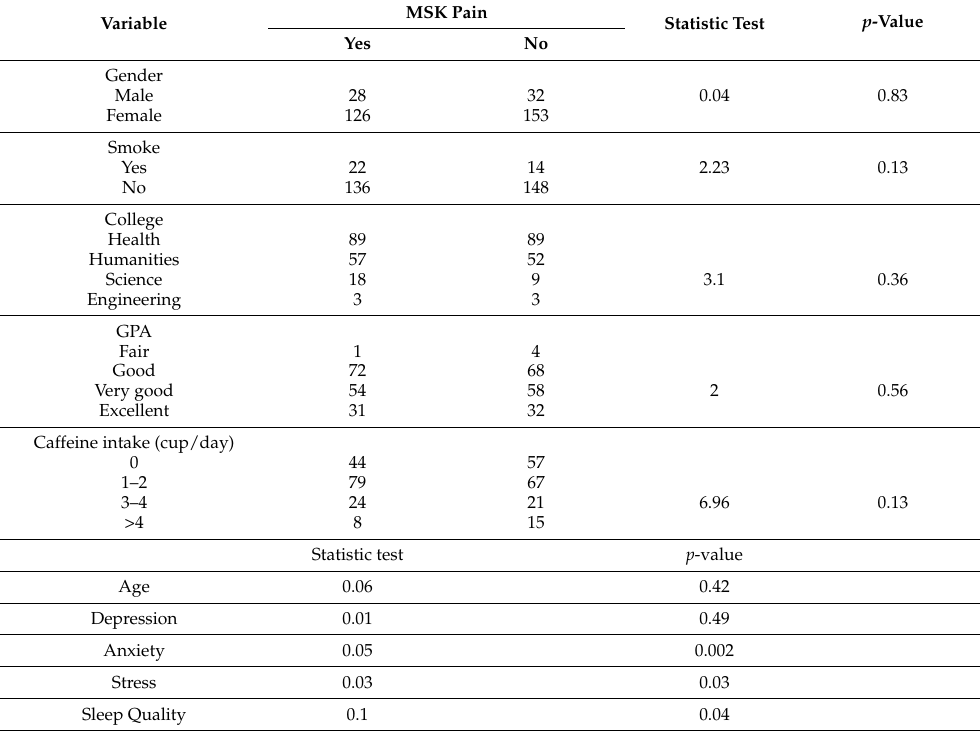
Table 4. Factors associated with reported MSKP pain in the past 12 months.